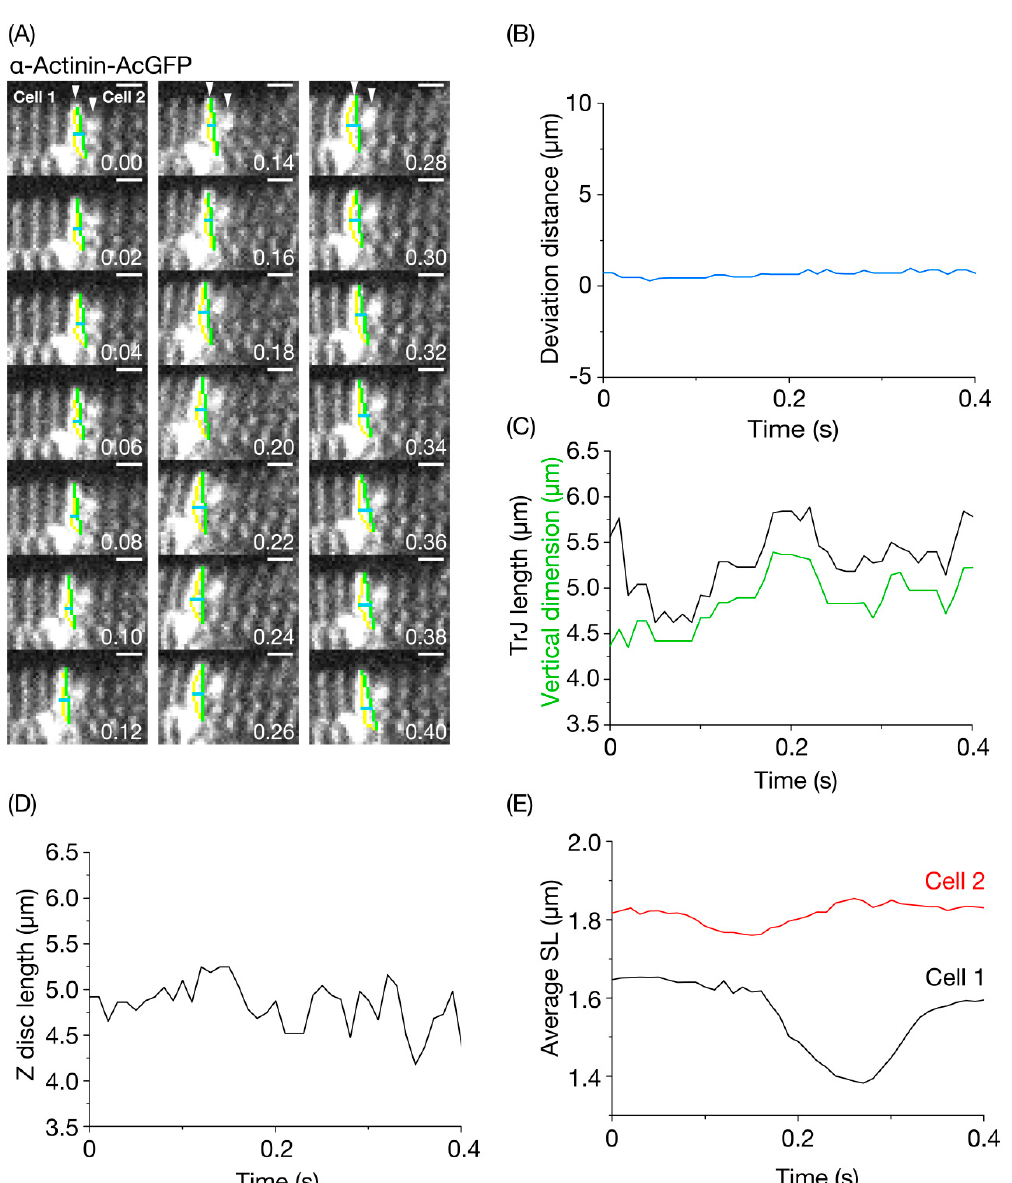
Figure 5. Imaging of the transitional junction in the α -actinin-AcGFP-expressing left ventricle of the living mouse heart in vivo. ( A ) Confocal images of the transitional junction (TrJ) at varying time points. Cell 1 and Cell 2 are located on the left and right side of the TrJ, respectively. Number on bottom right in each figure indicates the time point at which the image was obtained. The TrJ in Cell 1 is shown by a yellow trace. Green line, vertical dimension of the TrJ. Horizontal blue line, deviation of the central part of the TrJ from the mid-point of vertical green line (see Materials and Methods). The heart in an open-chest mouse was illuminated using a laser at 488 nm, and imaging was performed at 99 frames / s. Bar on top right, 2 µ m. See Movies S5 and S6. ( B ) Time course of changes in the deviation distance for the TrJ (shown in blue). Deviation distance was defined as the length of the horizontal blue line in ( A ). Changes in the deviation distance was very small (~0.8 µ m) as compared to Figure 2B (i.e., CellMask treatment). ( C ) Time course of changes in the TrJ length and vertical dimension. Black line, TrJ length (total length of yellow line in ( A )); green line, vertical dimension. The TrJ length and vertical dimension changed closely. The magnitude of change in the TrJ was on average < ~20%. ( D ) Time course of changes in the Z disc length. The Z disc located just next to the TrJ in Cell 1 was used for analysis. ( E ) Time-course of changes in mean SL in Cell 1 (black line) and Cell 2 (red line). The average length of 10 sarcomeres next to the TrJ was analyzed for both Cell 1 and Cell